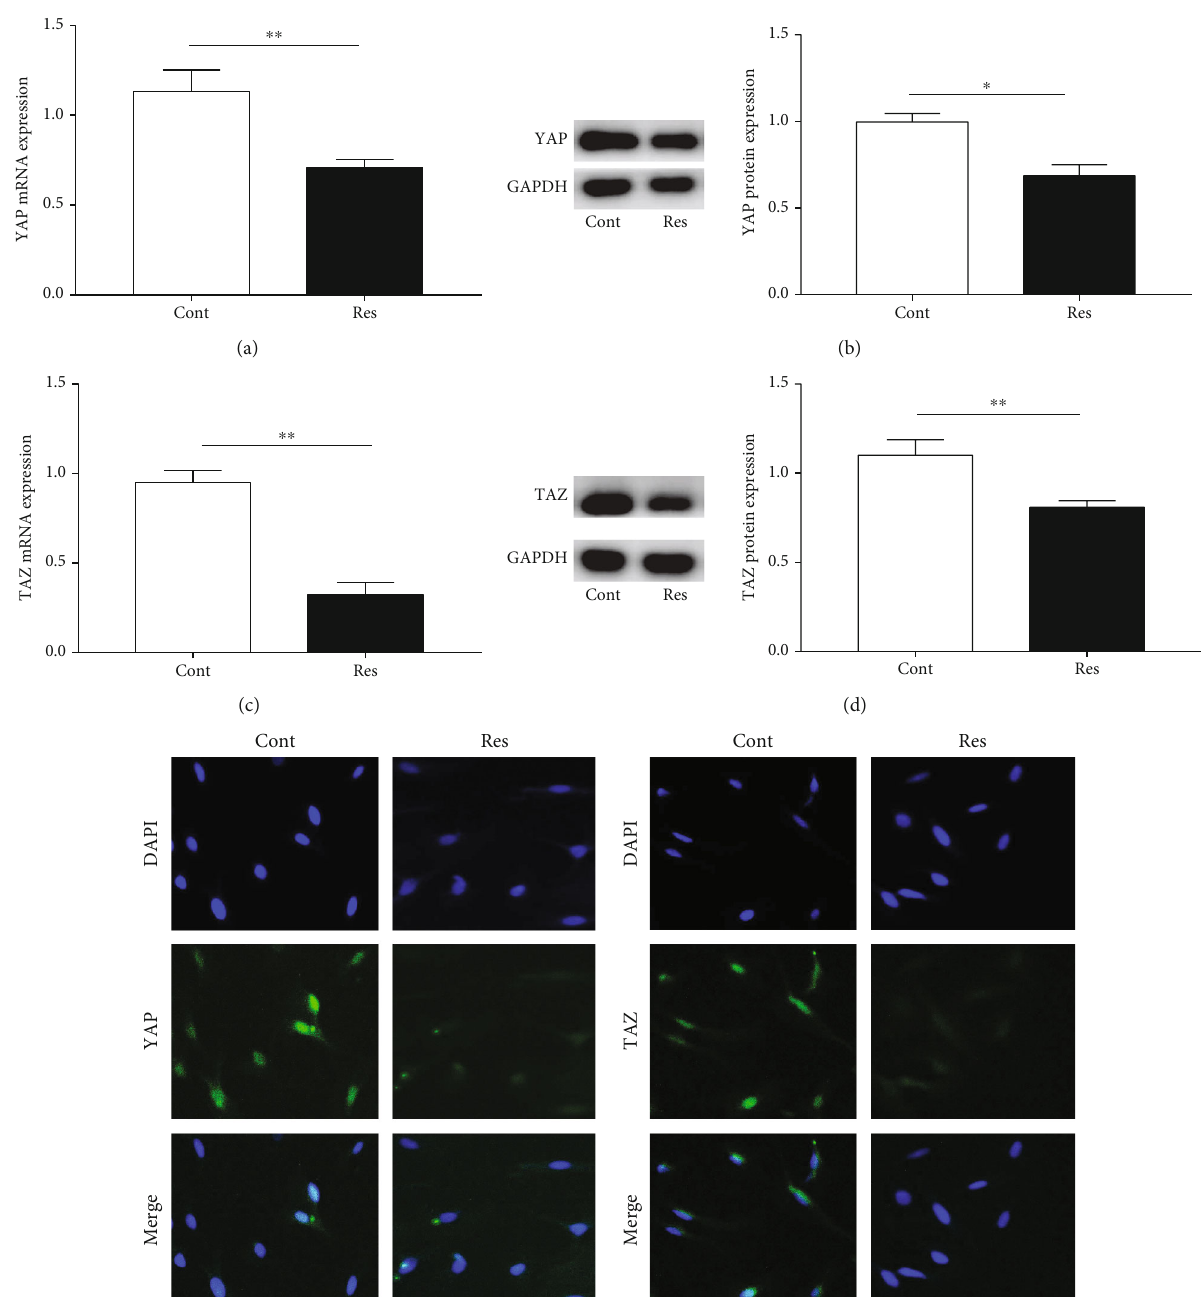
Figure 6: Res treatment enhances the Hippo pathway. (a) YAP mRNA expression. (b) YAP protein levels. (c) TAZ mRNA expression. (d) TAZ protein levels. (e, f) Immuno fl uorescence staining for YAP and TAZ. Nuclei are stained blue with DAPI. Original magni fi cation: × 200. Values are expressed as means ± SD . ∗ P < 0 : 05 and ∗∗ P < 0 : 01